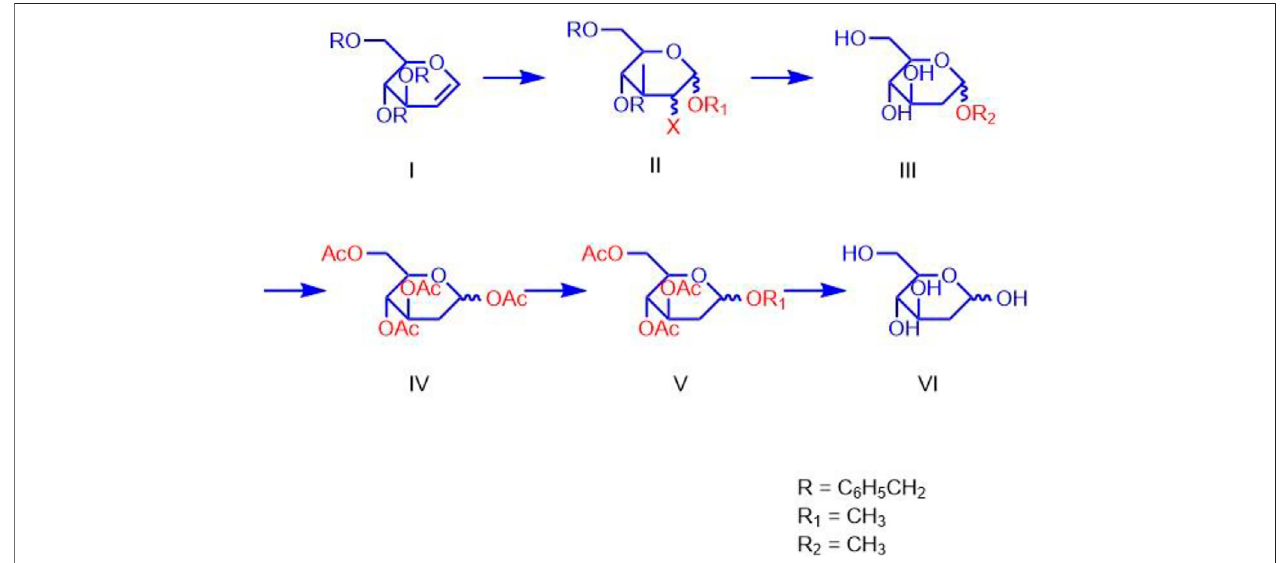
FIGURE 5 | Chemical Synthesis steps for the 2-deoxy-D-glucose.